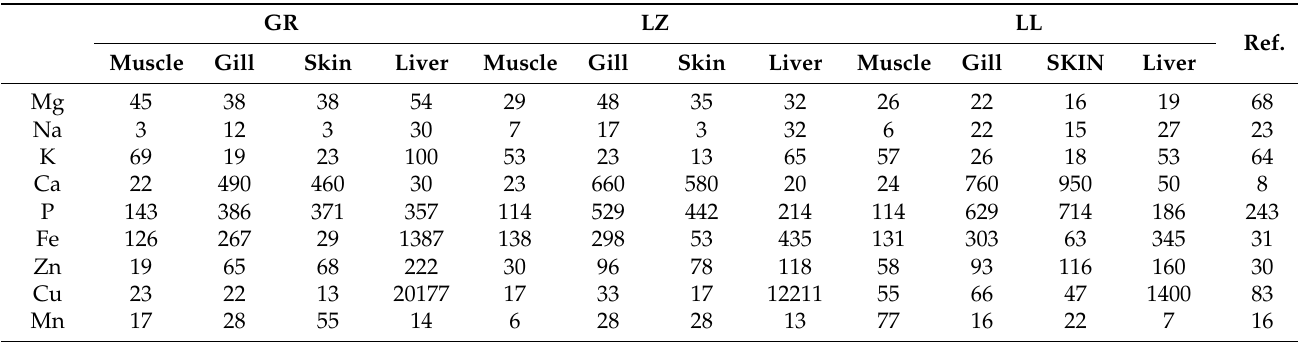
Table 5. Contribution (%) of Nile tilapia tissues from the three Ethiopia Lakes to dietary reference intake (DRI *) for females aged between 19 and 30, as an example (compared with USDA standard reference).